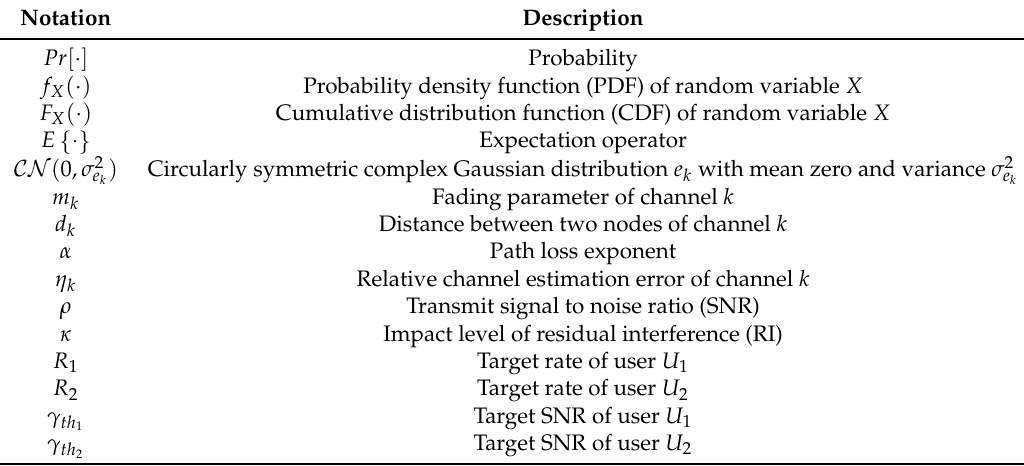
Table 2. The main notations used in this paper.